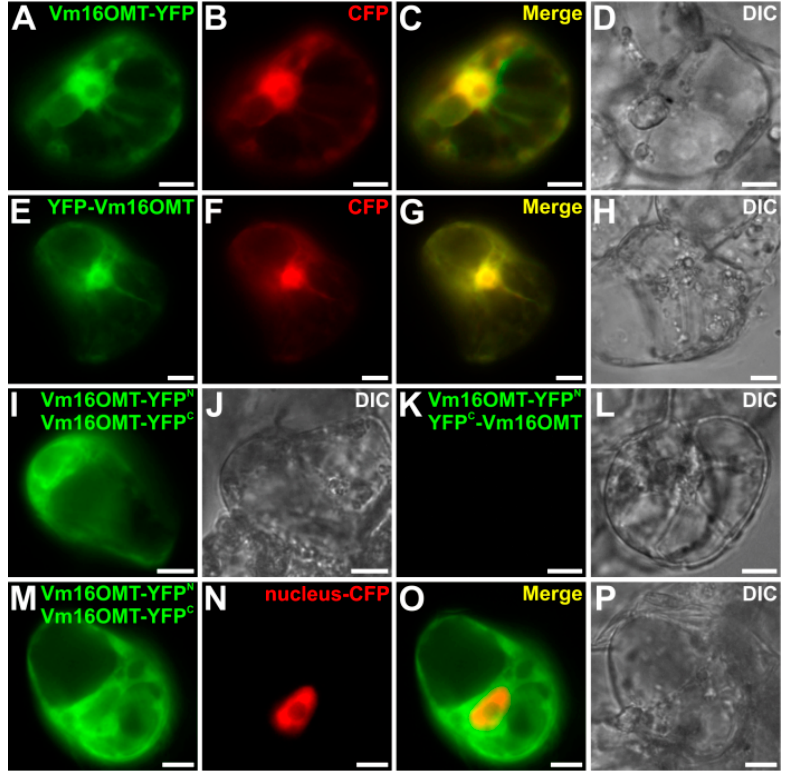
Figure 9. Subcellular localization of Vm16OMT in C. roseus cells. Vectors containing Vm16OMT-YFP ( A – D ) and YFP-Vm16OMT ( E – H ) were transiently co-expressed in C. roseus cells with a nucleocytoplasmic (CFP) marker. Bimolecular fluorescence complementation (BiFC) analyses ( I – P ) were performed by transiently co-expressing the corresponding constructs described in the upper right of each panel. A nuclear-CFP marker was included ( N ). Colocalization of the YFP and CFP fluorescence signals appear in the merged image. Cell morphology was observed using differential interference contrast (DIC). Bar 10 µm.